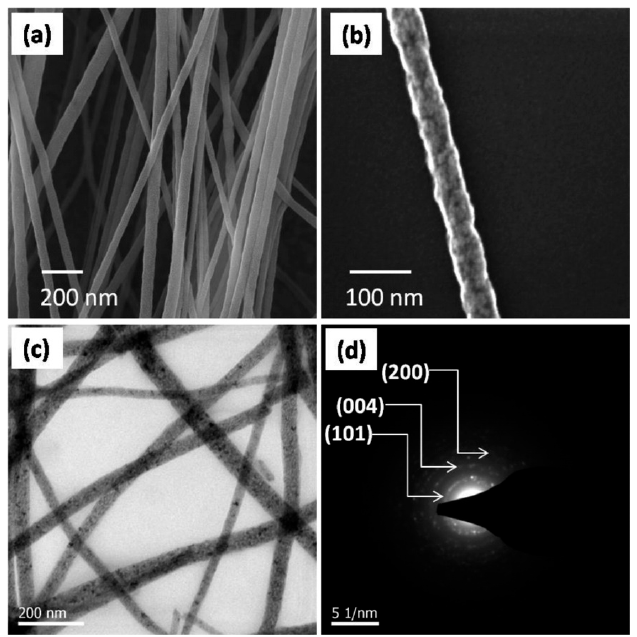
Figure 6. FESEM images of a TiO 2 nanofiber mat produced upon the calcination of PVP/PVP/Ti(OiPr) 4 composite fibers at 500 °C ( a ); a single titania nanofiber ( b ); a TEM image of the fibers ( c ); and a SAED pattern displaying the crystal planes of the anatase phase of TiO 2 ( d ). The arrows indicate different crystal planes of TiO 2 . Reprinted with permission from [15]. Copyright (2014) American Chemical Society.